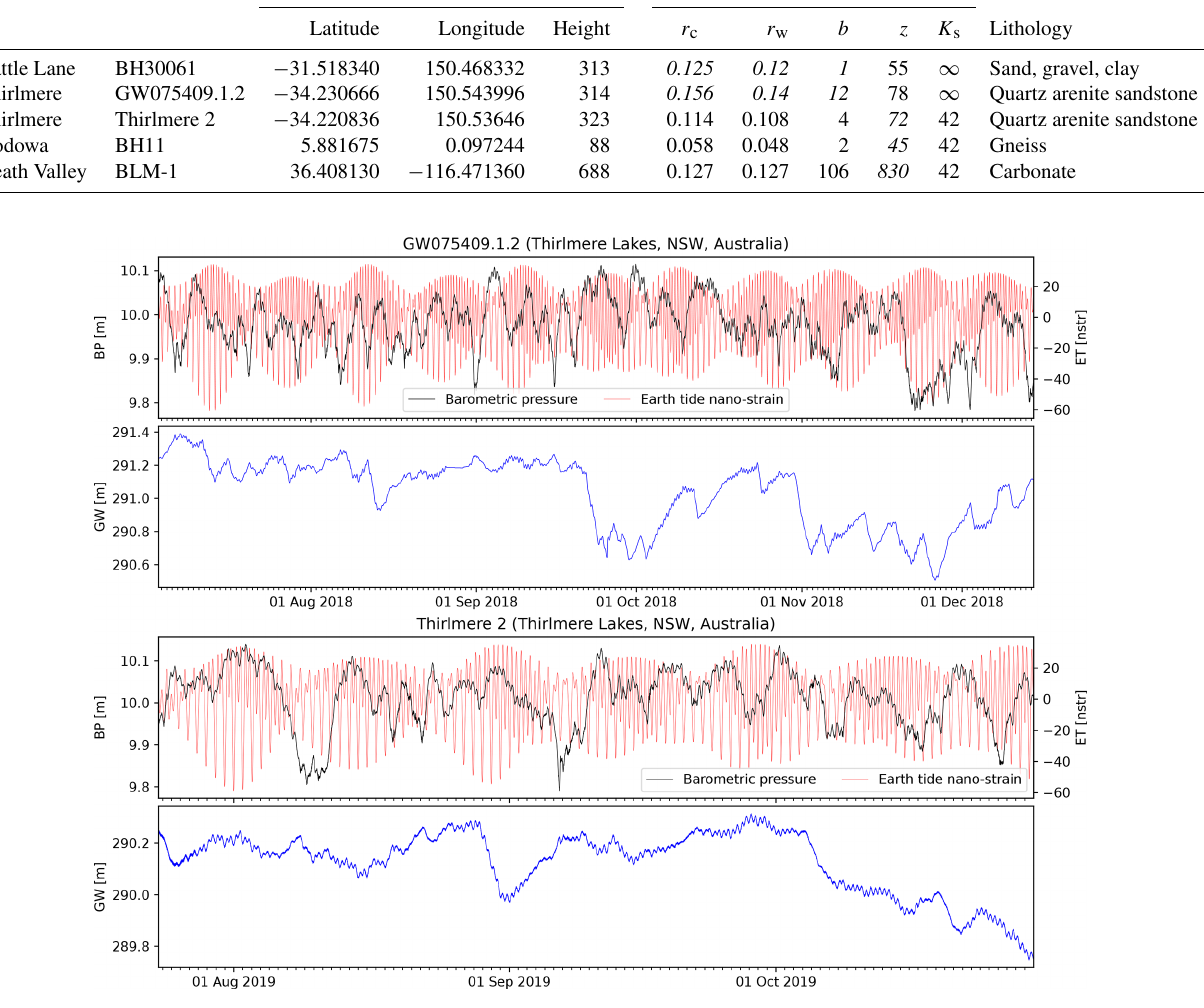
Figure 4. Time series of groundwater levels from bores GW075409.1.2 and Thirlmere 2 located at Thirlmere Lakes (NSW, Australia), barometric pressures (in metre-equivalent water heights for easier comparison to the groundwater pressure heads), corresponding theoretical Earth tides (in nano-strain, nstr) calculated using PyGTide